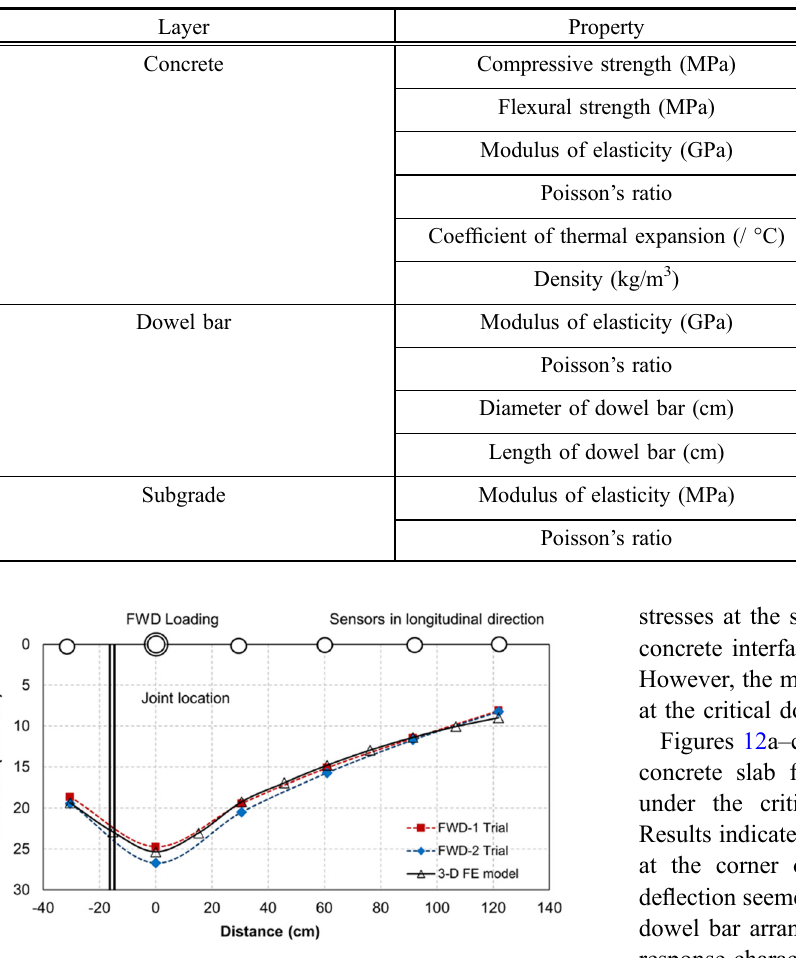
Fig. 11 Matching of deflection basin across the doweled joint.